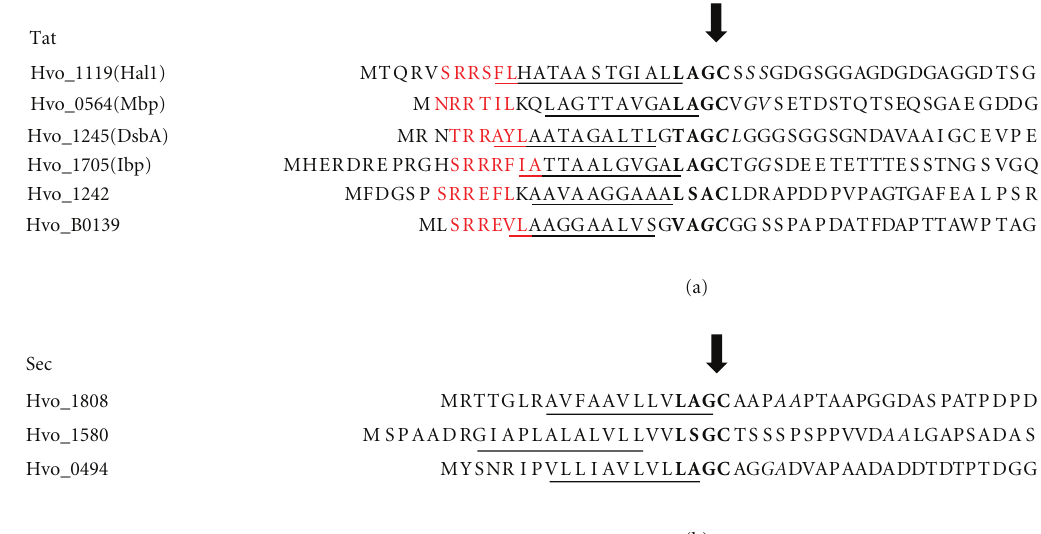
Figure 1: Tat and Sec signal peptides containing lipobox motifs. N-terminal regions of the precursors of (a) Tat; and (b) Sec substrates with lipoboxes (bold) predicted by at least two of the three lipoprotein prediction programs (PredLipo, LipoP and Prosite PS51257), with the exception of Hvo 1242, which was only LipoP-positive. Tat motifs (red) were predicted by TatFind, hydrophobic stretches (underlined), and SPase I cleavage sites ( italics ) were predicted by Phobius. An arrow indicates the predicted SPase II cleavage sites.